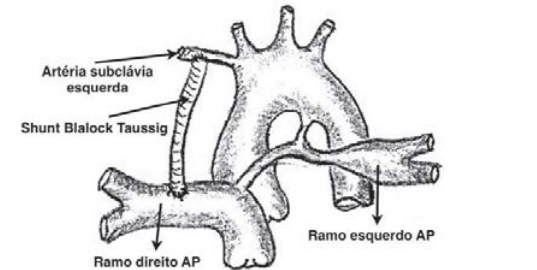
Fig. 2- Confecção do shunt sistêmico-pulmonar, Blalock Taussig modificado, da artéria subclávia até a artéria pulmonar contralateral ao PCA com tubo de politetrafluoretileno (PTFE) de 4 ou 5 milímetros anastomosado com sutura contínua com fio de polipropileno 7-0